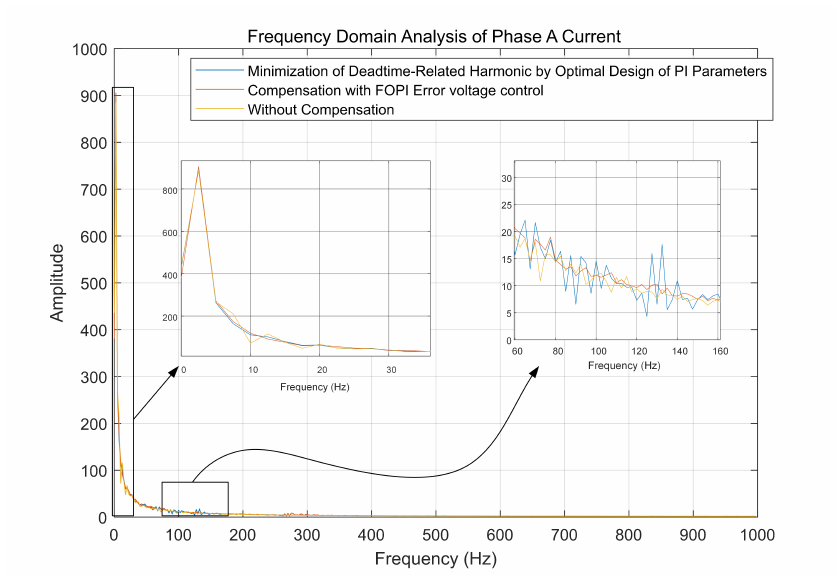
Figure 33. Frequency domain analysis of A phase current under 200 r/min speed conditions (the method with optimal IOPI error voltage control and the minimization method of deadtime-related